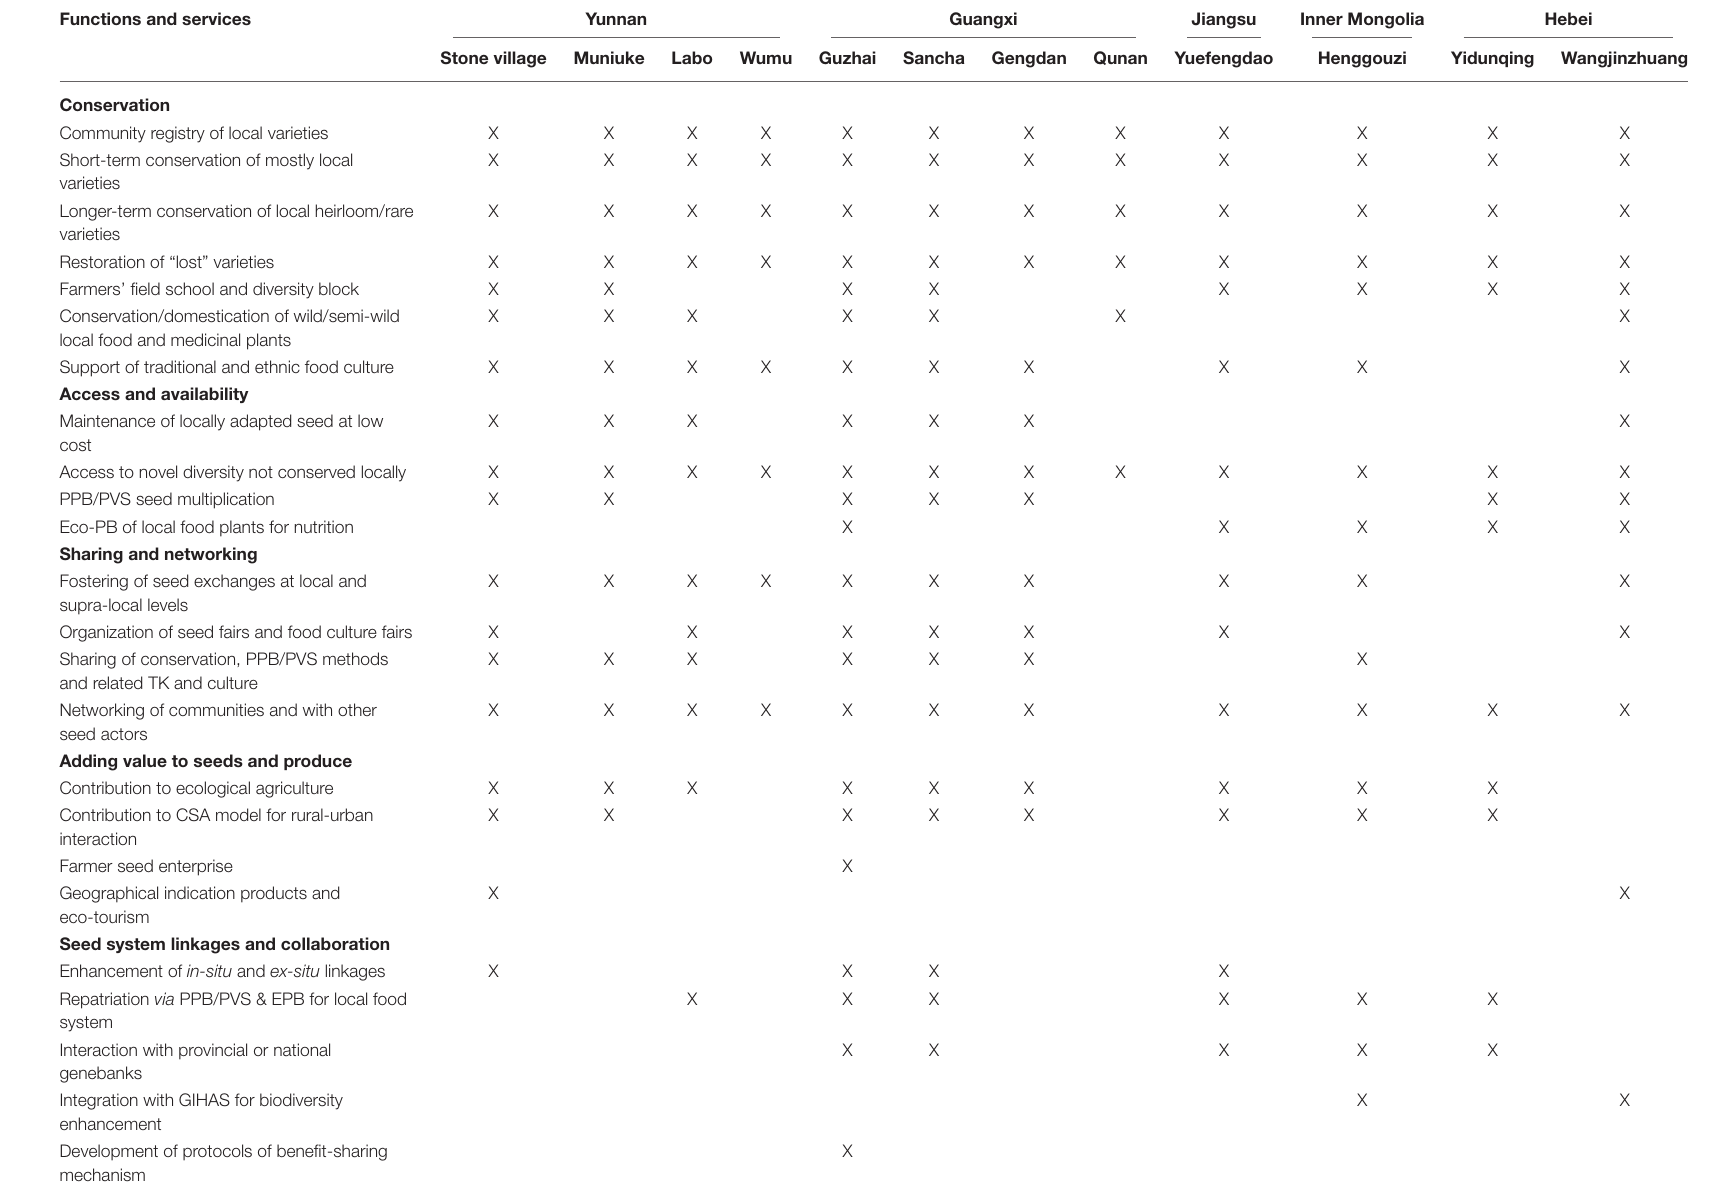
TABLE 2 | Main functions and services of community seed banks in China supported by the Farmers’ Seed Network ( n = 12). Functions and